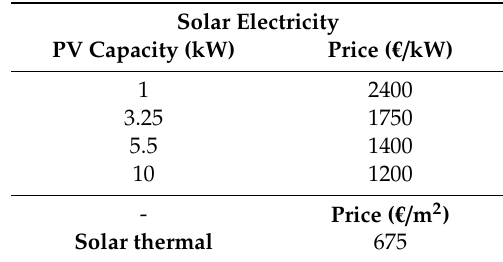
Table 7. Solar energy system costs. The flat-plate solar thermal cost also includes the required thermal storage tank. [12,58].